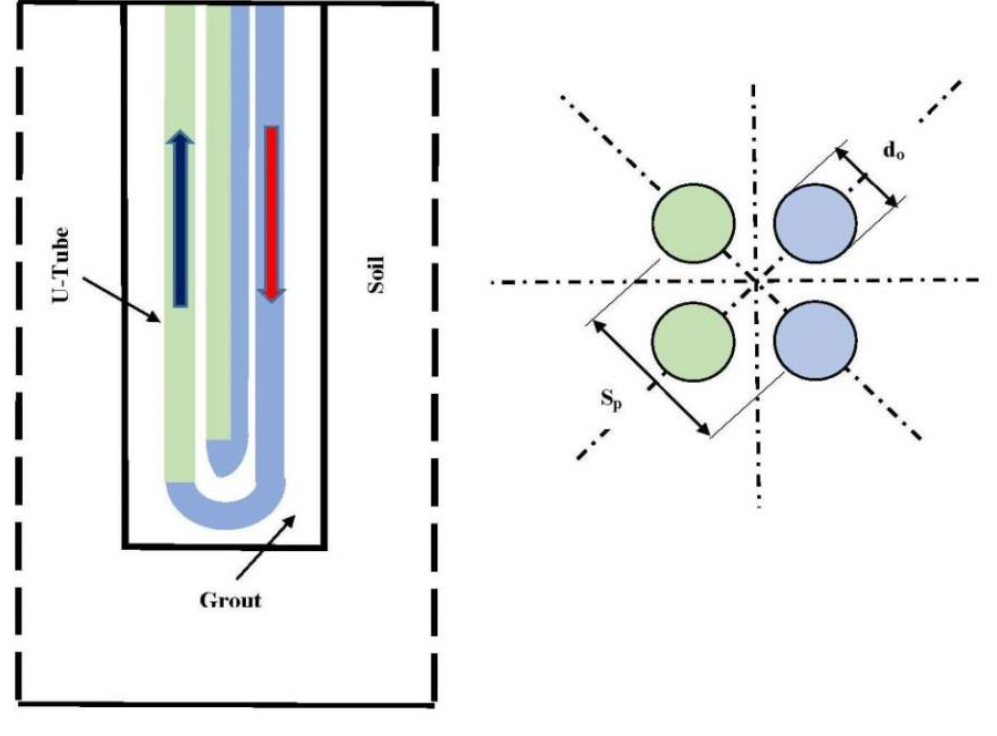
Figure 1.b. Double U-tube heat exchanger Figure 1. Investigated heat exchanger geometry orientations.